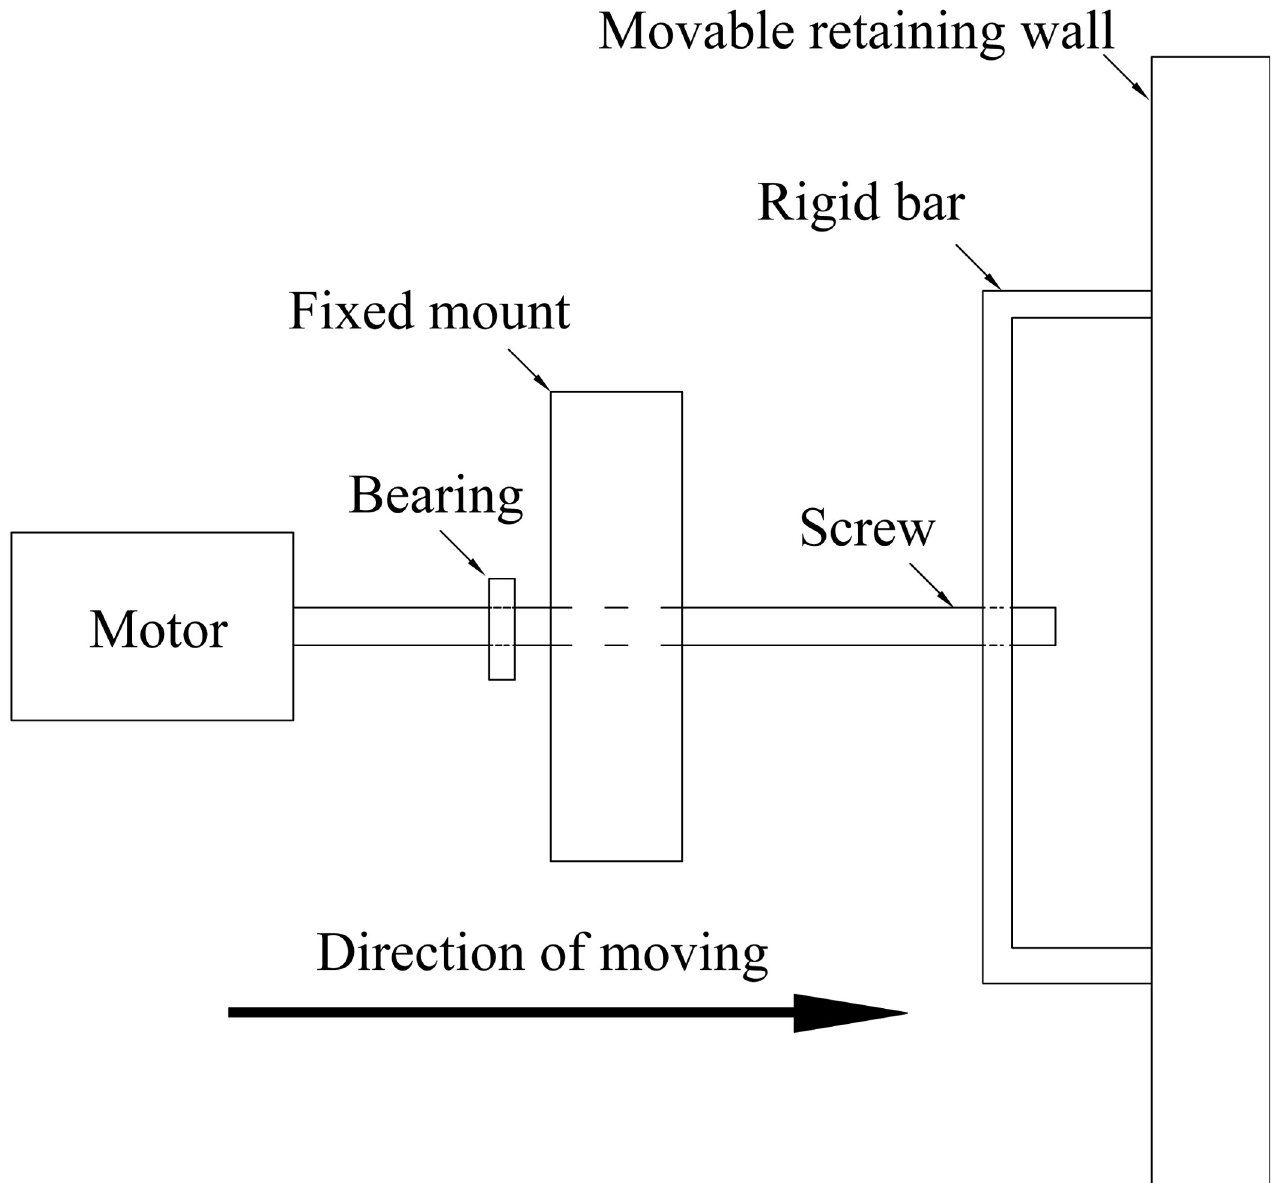
Fig 3. Motion control device of movable